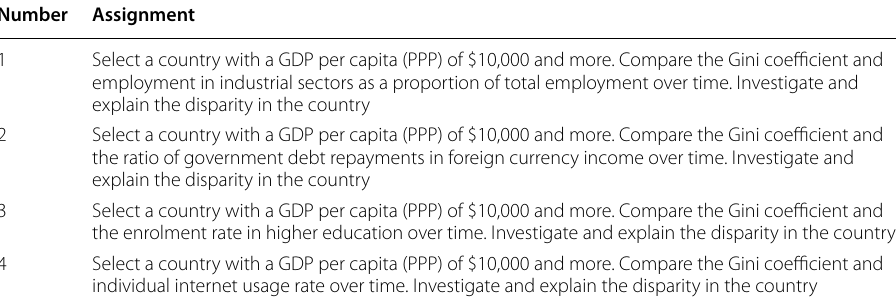
GDP gross domestic product, PPP purchasing power parity